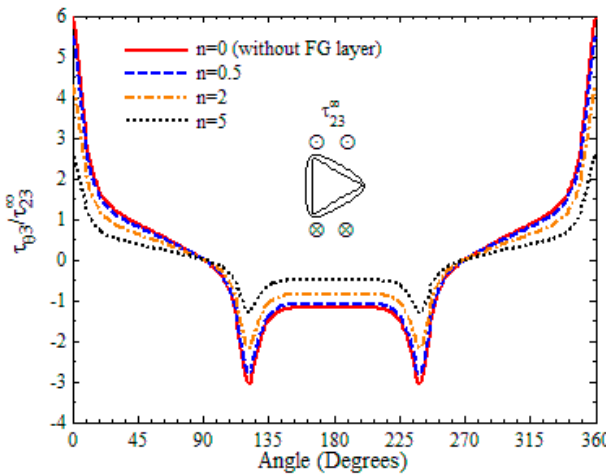
τ around the hole (triangle). Figure 5. The variation in shear stress τ θ 3 around the hole (triangle). 3 θ